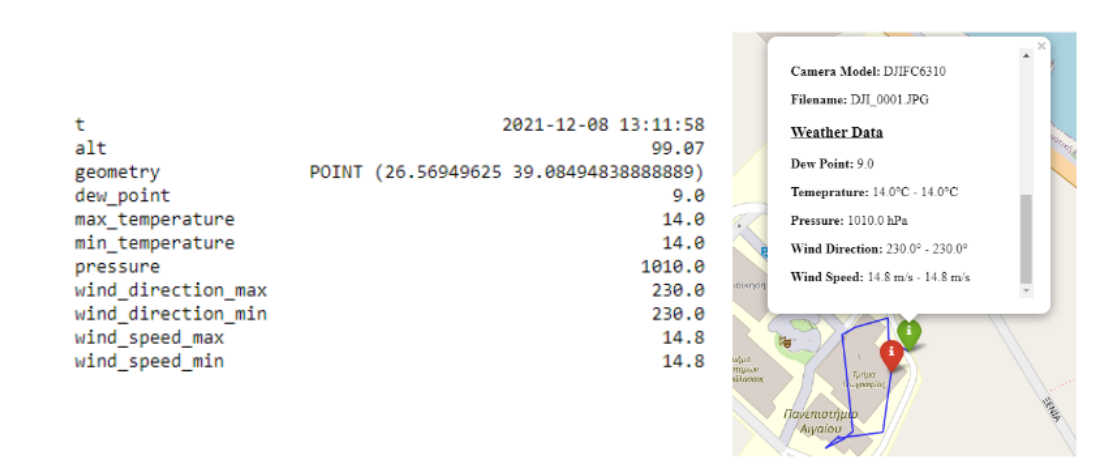
Figure 9. Weather data obtained using open Web services.